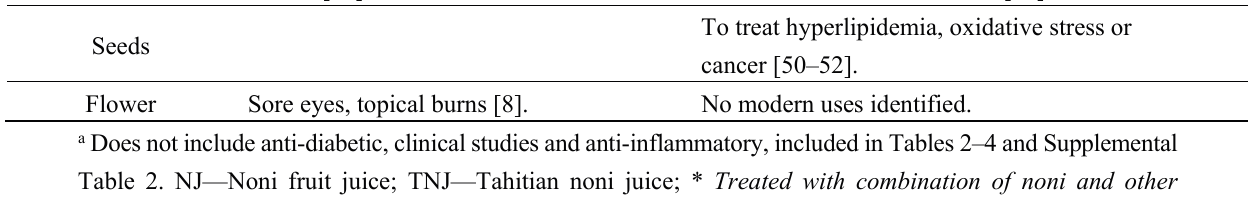
Table 2. NJ—Noni fruit juice; TNJ—Tahitian noni juice; * Treated with combination of noni and other traditional